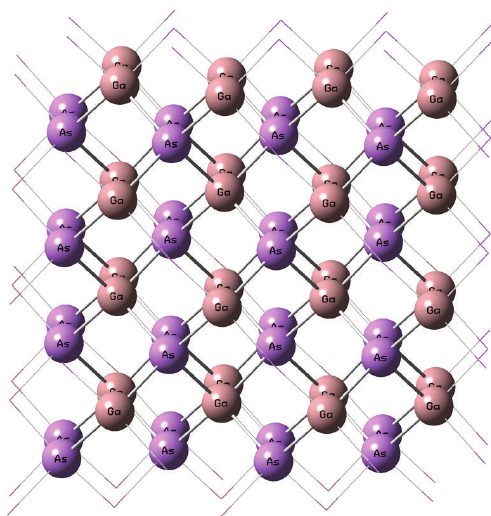
Figure 2: (Color online) 64 atoms at the core of GaAs nanocrystal as viewed by the LUC